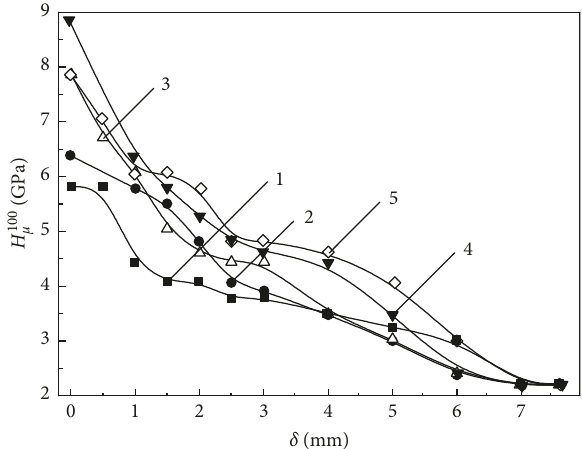
Figure 5: Microhardness of 40Kh steel after the V SO with du- ration of treatment: (1) 6; (2) 12; (3) 20; (4) 28; (5)